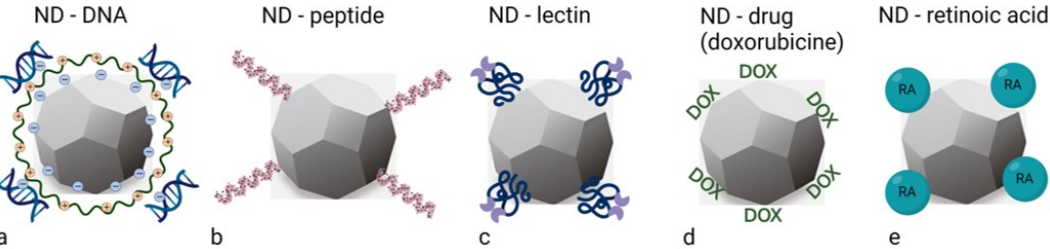
Figure 2. Useful functionalisation of NDs by non ‐ covalent binding of DNA ( a ), peptide ( b ), lectin ( c ), drugs such as doxorubicin (DOX; ( d )) and retinoic acid (RA; ( e )) [6,21,48]. The illustration was created by the authors using the BioRender app.